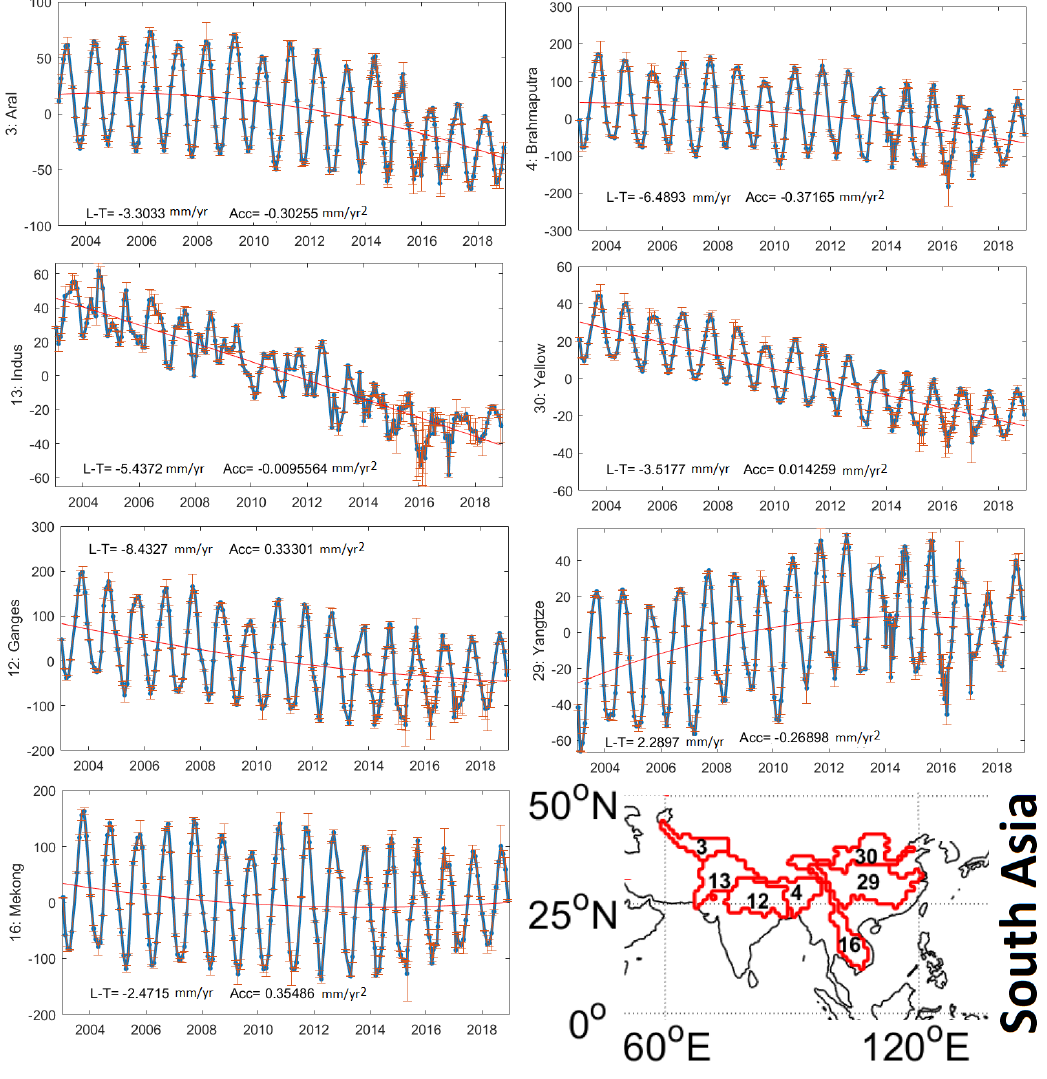
Figure 12. Basin average of the reconstructed TWSC fields within the seven major river basins of South Asia covering 2003–2018. The red lines show the long-term linear trend (L-T (mm/yr)) and acceleration (Acc (mm/yr 2 )) components fitted to the TWSC